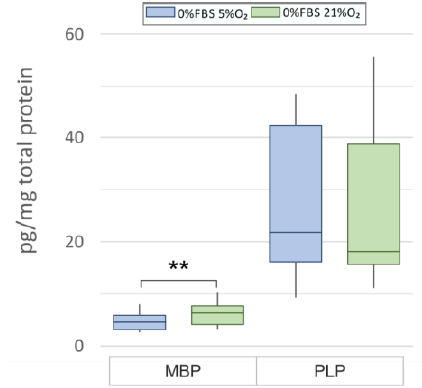
Figure 5. Quantitative analysis of the major myelin components in oligodendrocytes cultured in distinct oxygen concentrations (physiologically relevant 5% O 2 versus standard 21% O 2 ) on the 5th DIV. Statistical significance is ** p < 0.01.